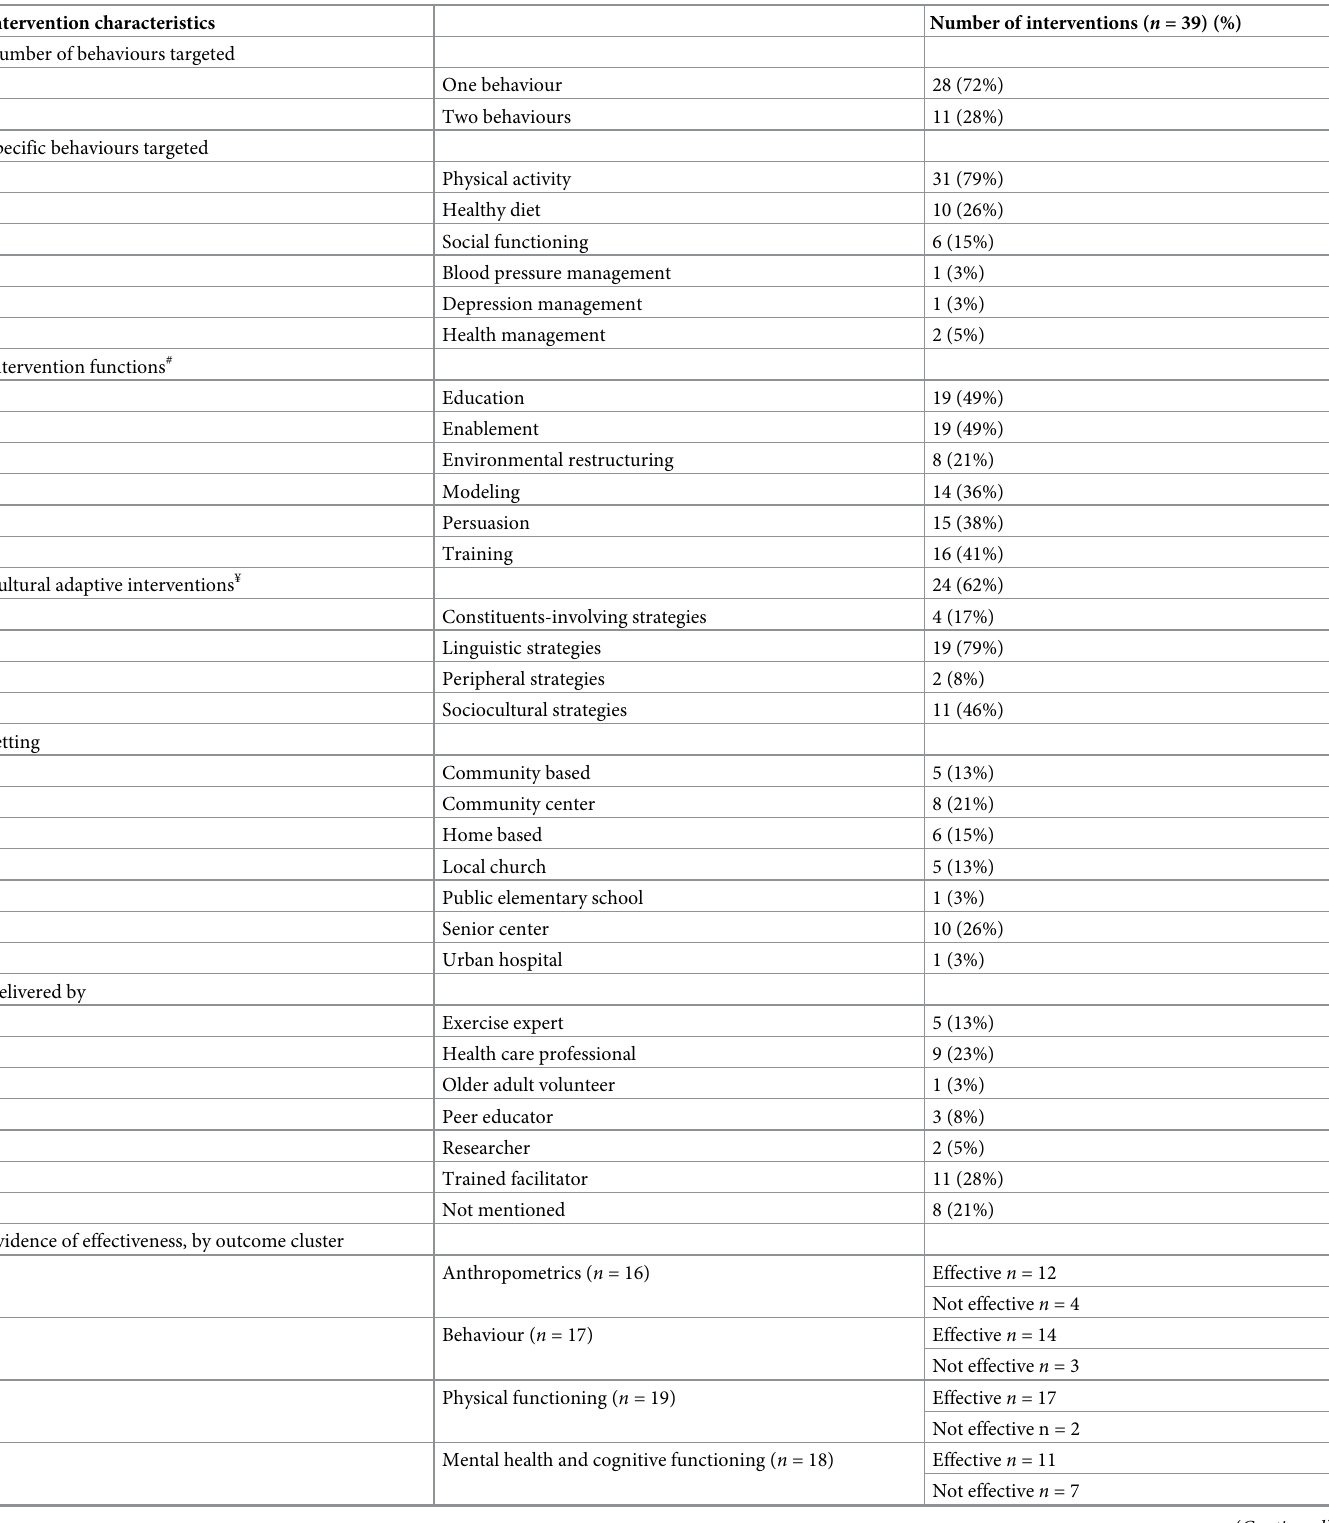
Table 1. Summary of intervention characteristics ( n =